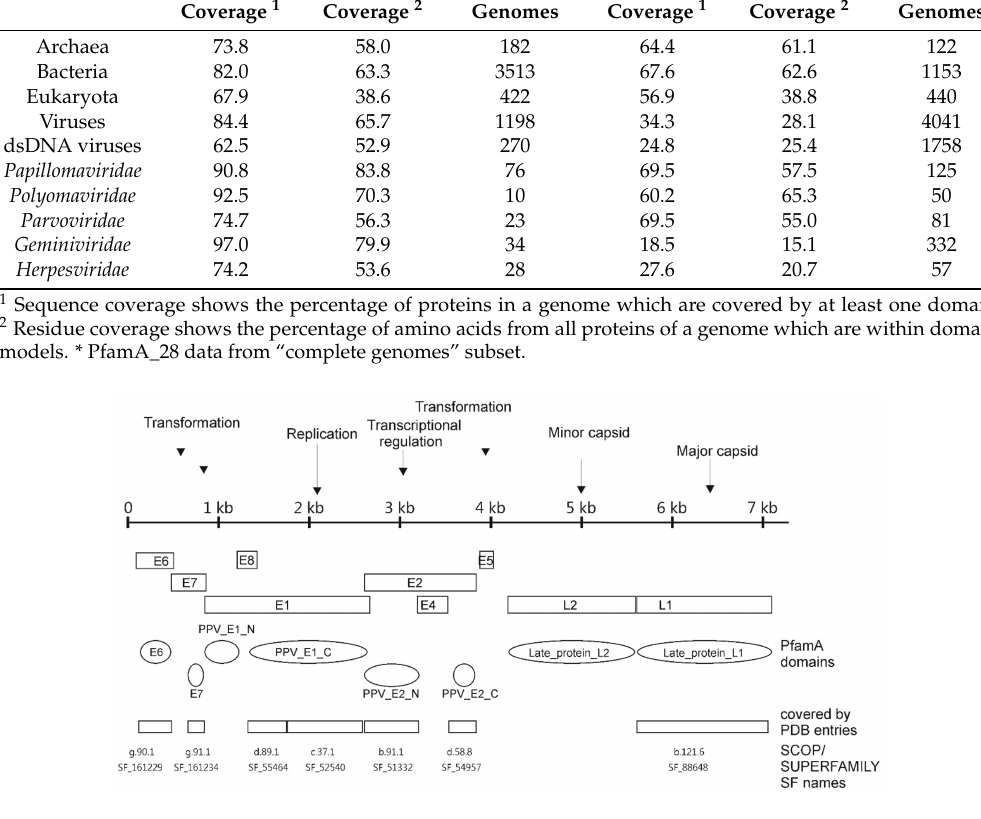
Figure 1. Location of Papillomavirus (PV) proteins and protein domains using Bovine PV type 1 as an example. Bovine PV type 1 encodes 9 proteins including the oncoproteins E6, E7 and E5, the viral helicase E1, the helicase loading factor and transcription factor E2, and the L1 and L2 coat proteins. E8ˆE2 and E1ˆE4 proteins are not shown on the figure. Location of open reading frames (ORFs) does not correspond to reading